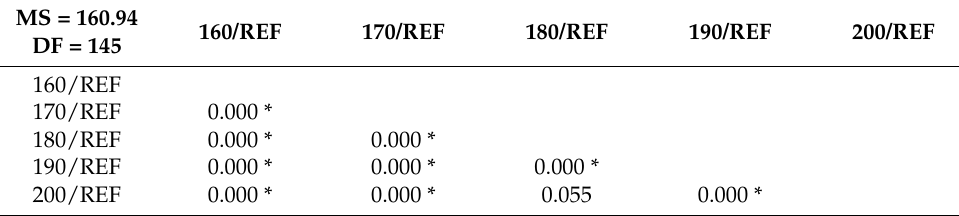
Table A8. Duncan ´ s multiple range test for changes in colour parameter a.